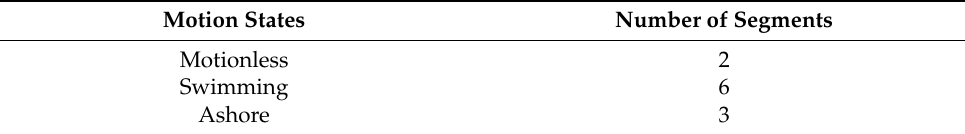
Table 3. Summary of the EEG signal segmentations.